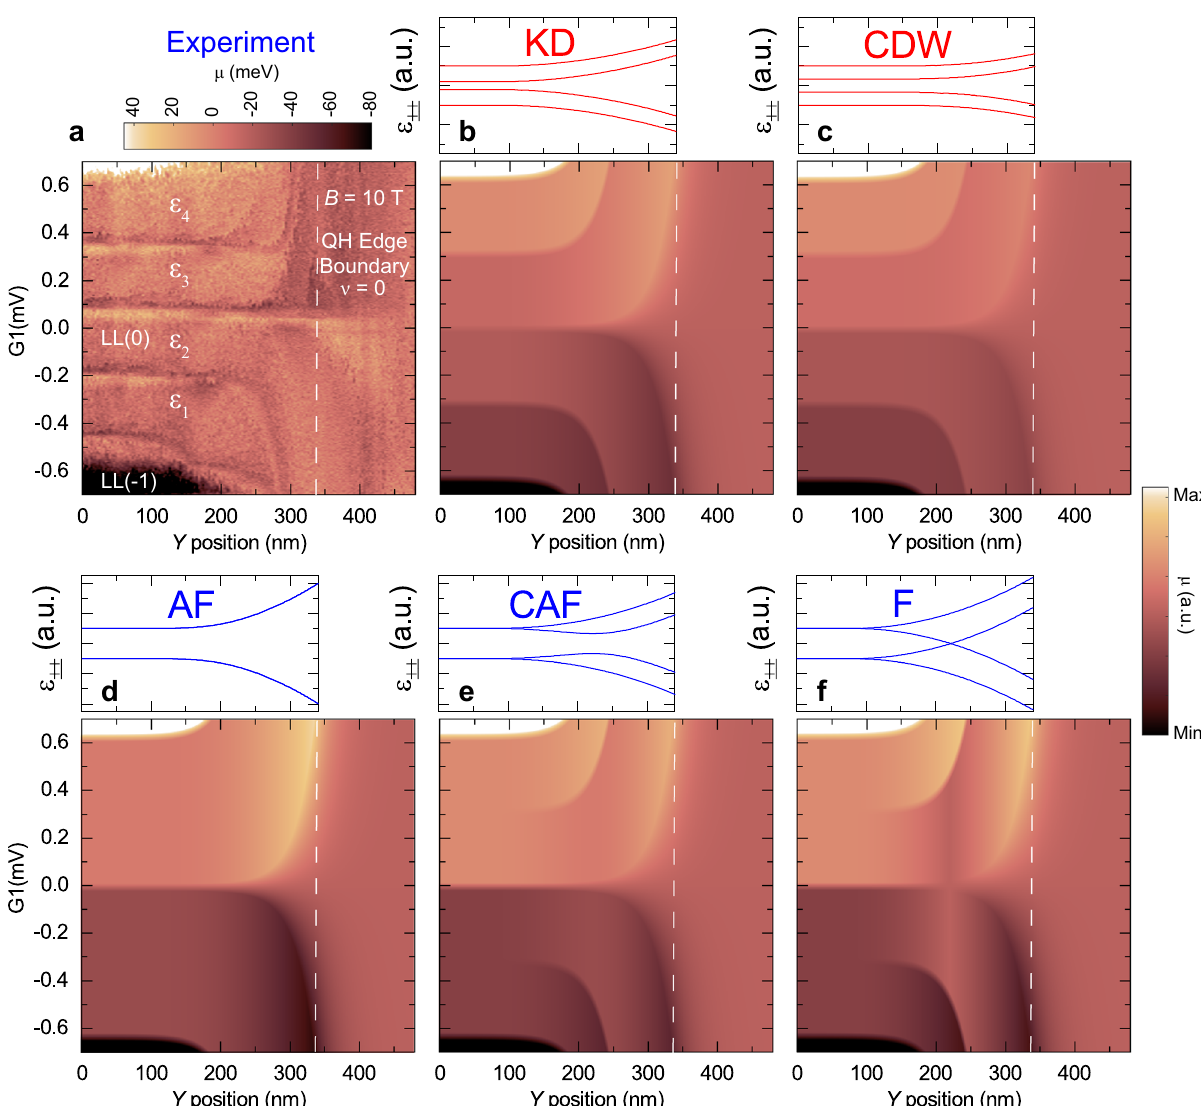
Fig. 6 A comparison of the experimental Kelvin probe map of the graphene broken-symmetry edge states with different ground-state symmetries. a Kelvin probe map at B ¼ 10T of the chemical potential as a function of Y -position across the QH boundary from Fig. 5b. b – f (top panels) Schematic dispersion of the four single-particle energy levels ε ±± for different phases obtained from the analytic formulas in Table 1 of ref. 29 . (bottom panels) Simulation of the Kelvin probe maps of the chemical potential vs. local gate and Y -position using the dispersions of the various ground-state symmetries in the top panels along with the measured gate response pro fi le in the G1- Y plane obtained at B ¼ 0T, as shown in Fig.